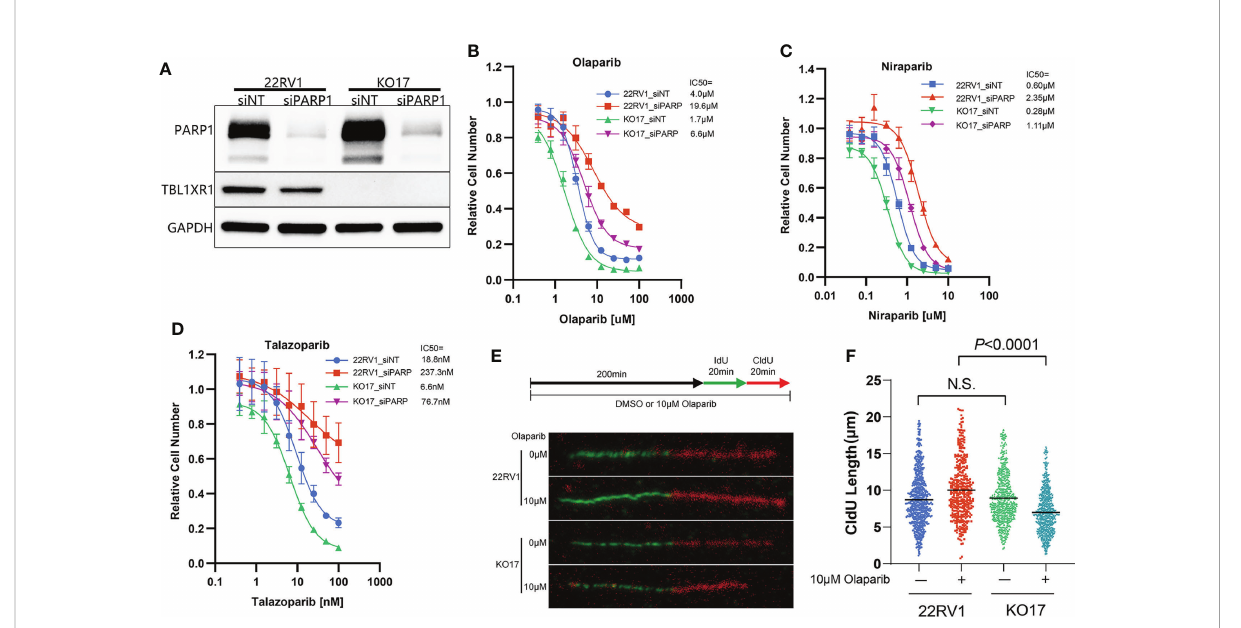
FIGURE 3 TBL1XR1-de fi cient sensitizes prostate cancer cells to PARPi partially dependent on PARP trapping and drives the cells to suffer more serious DNA replication stress. (A – D) siRNA of PARP1 knockdown PARP1 protein ef fi ciently (A) and both WT and TBL1XR1-de fi cient cells reverse sensitivity to olaparib (B) , niraparib (C) and talazoparib (D) when transfected with PARP1 siRNA. (E, F) DNA fi ber assays of WT and TBL1XR1- de fi cient cells under vehicle or 10 m M olaparib treatment for 4h (as the diagram in E). Representative images of DNA fi bers of different groups are shown in (E) . Quanti fi cation of red fi ber (CldU labeled) length from the ongoing replication was done using the ImageJ software (NIH). At least 200 fi bers were measured for each group. P values calculated by two-tailed Student ’ s t-test. N.S. indicated not signi fi